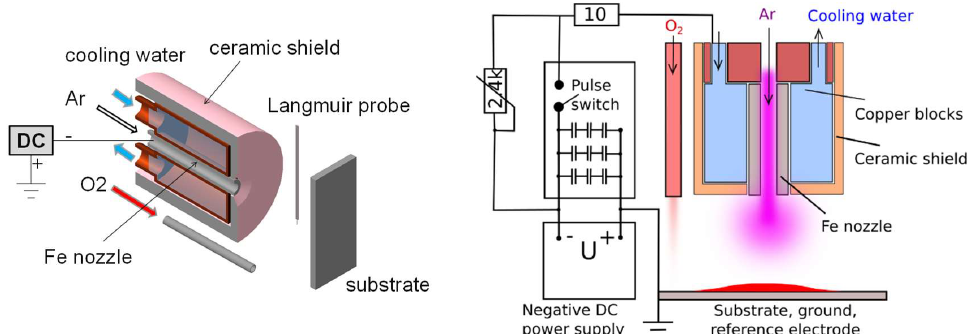
Figure 2. Cross-section of the hollow cathode sputtering system with DC power supply (left) and a schematic of the same hollow cathode with electric circuit for pulsed DC operation mode (right). Both systems are depicted without the vacuum chamber.